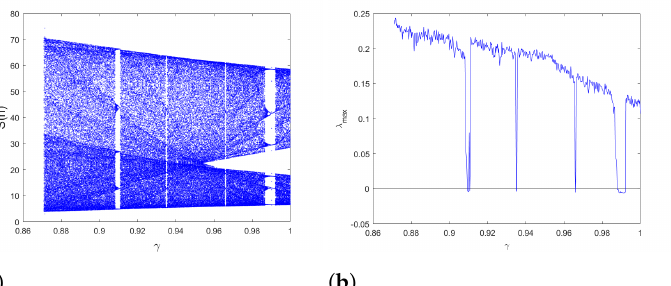
Figure 7. ( a ) Bifurcation diagram versus γ of the fractional discrete SIR model (11) with α = 4. ( b ) The maximum Lyapunov